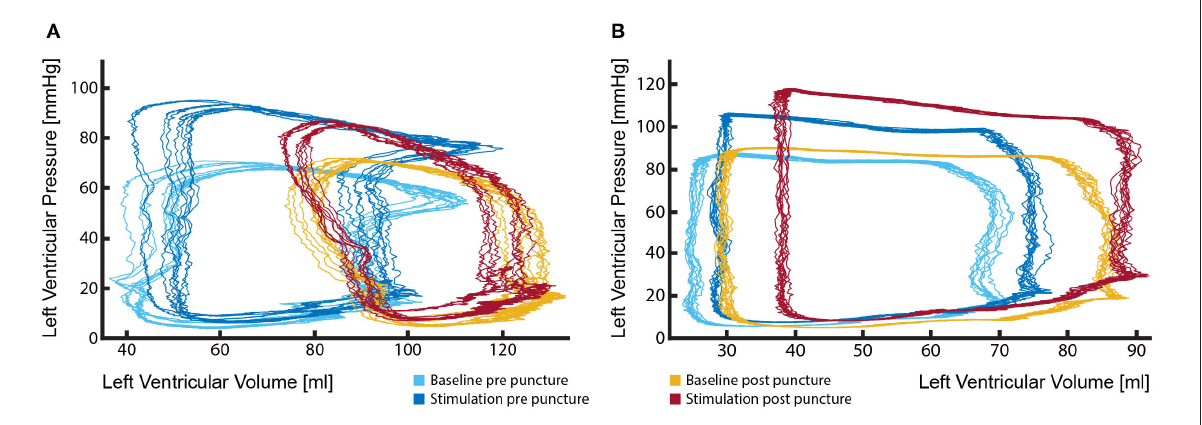
FIGURE7 Stable position of the PV loop catheter during the entire procedure is fundamental for the evaluation of the effects of aortic regurgitant jets on left ventricular performance. (A) Marked change in PV loop curves following the removal and reinsertion of the catheter after the defect creation. Such changes render the comparison of the LV performance between the healthy state (light and dark blue loops) and aortic insufficiency state (red and yellow loops) particularly challenging and potentially misleading; (B) By keeping the catheter in a stable position during the entire procedure reliable measurements could be performed, delineating effects that aortic regurgitation causes to LV performance (light blue vs. yellow loops). Furthermore, investigations under pharmacologically changed hemodynamic conditions are possible (dark blue vs. red